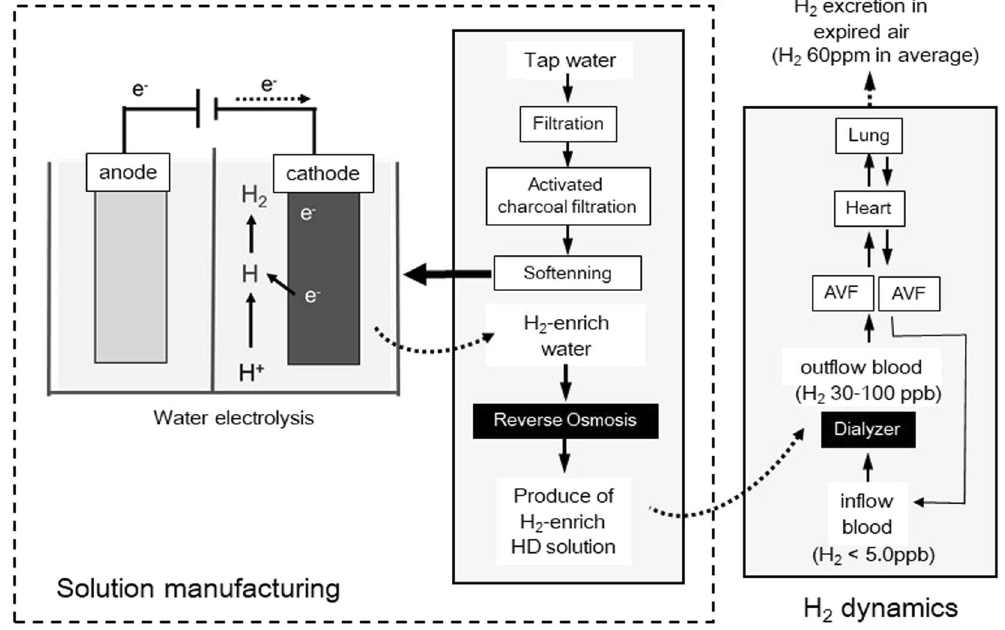
Figure 4. Manufacturing process of haemodialysis solution in the E-HD and H 2 dynamics during treatment by E-HD. Abbreviations: E-HD, electrolyzed water haemodialysis; e-, electron; AVF, arterio-venous